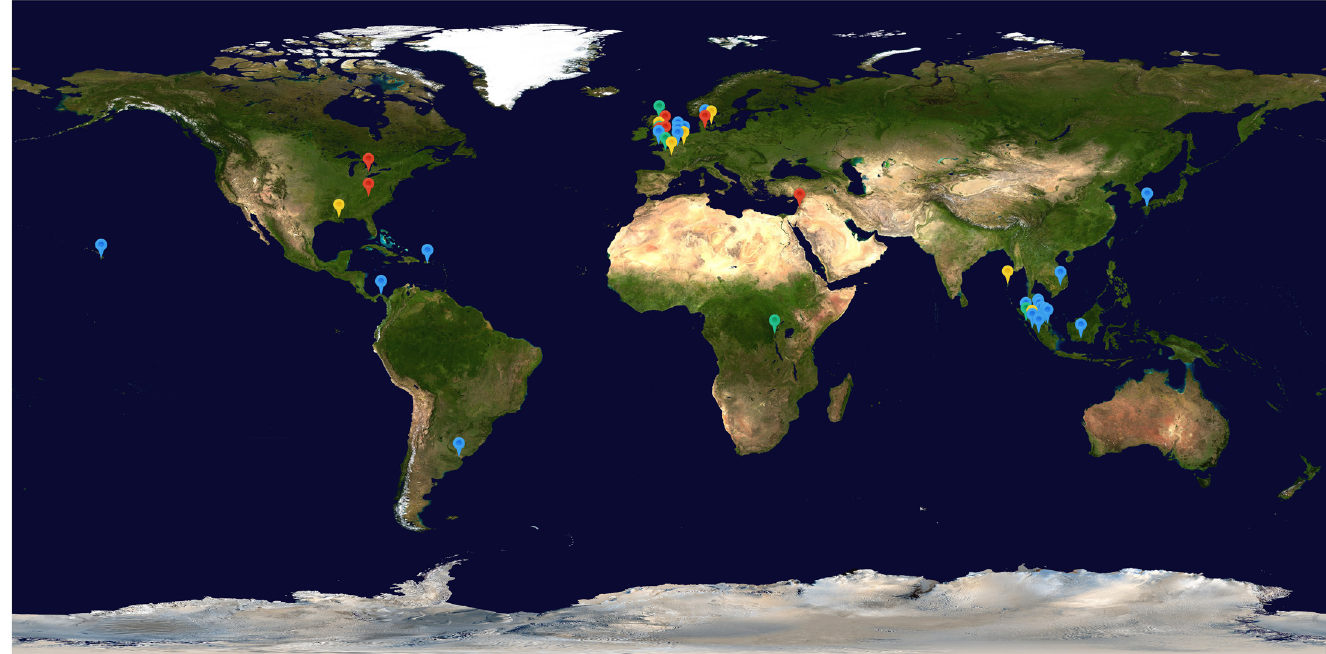
Fig 2. Location of patient series included in the review, colour coded according to series mortality. Blue = 0 – 5%, Green = 5 – 10%, Yellow = 10 – 20% and Red = > 20%. Map image: NASA – Visible